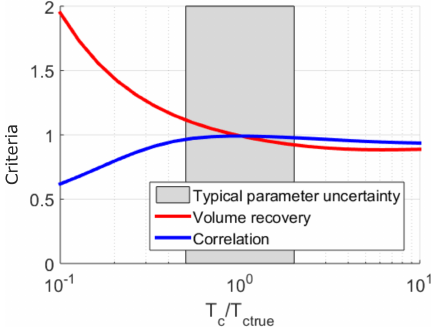
Figure B3. Impact of uncertainties on the estimation of charac- teristic time t c on recharge amplitude (defined by the “volume re- covery”, equal to the ratio between inferred and true mean annual recharge amplitude) and timing recovery (defined by the correlation coefficient). The gray rectangle defines the typical uncertainty on estimated characteristic